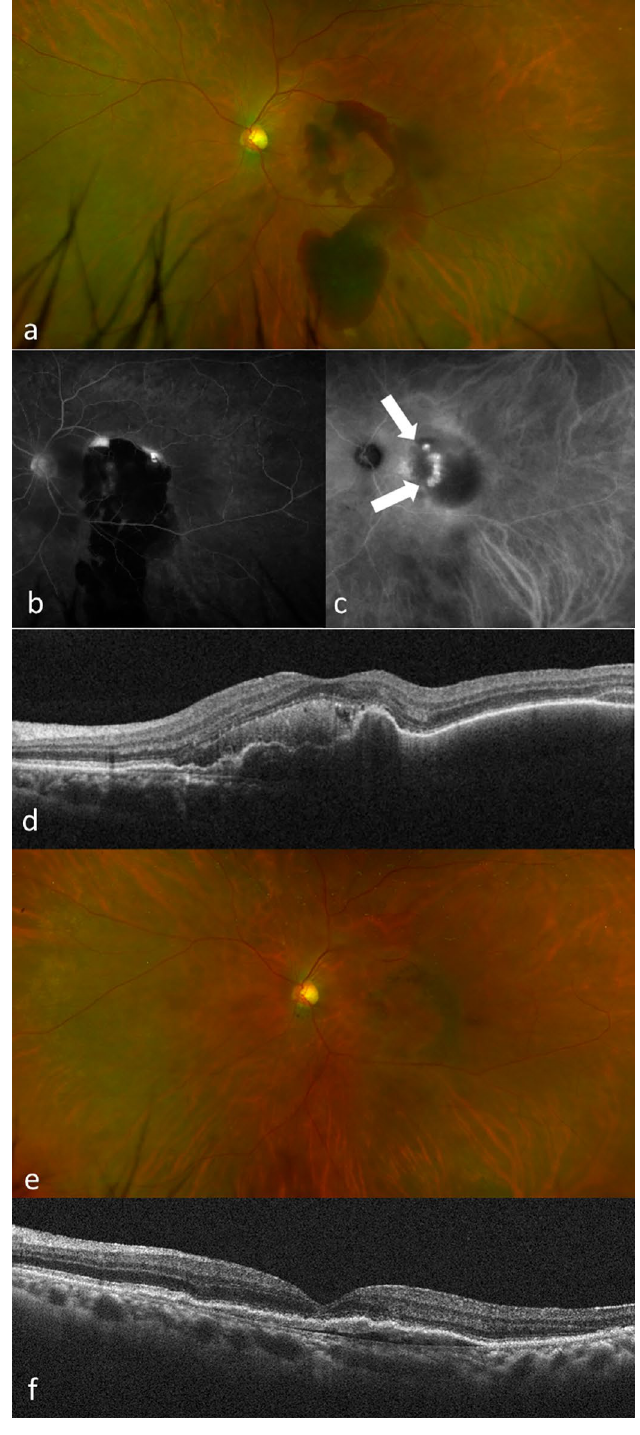
Figure 4. ( a ) A 67-years-old man presented with visual loss in his left eye (BCVA 20/100). Examination shows a SMH in the macula extending outside the vascular arcade. ( b ) Fluorescein angiography shows blockage due to the hemorrhage and hyperfluorescent area. ( c ) Indocyanine green angiography shows a polypoidal lesion (arrows). ( d ) A baseline OCT image shows a SMH at the fovea and hemorrhagic PED. He was diagnosed with PCV. He received IVBr treatment during the loading phase and received IVBr every 2 months during the maintenance phase. ( e ) Fundus photography at 1 year shows improvement of the SMH. ( f ) OCT at 1 year shows resolution of the SMH and reduced PED. The BCVA improved slightly to